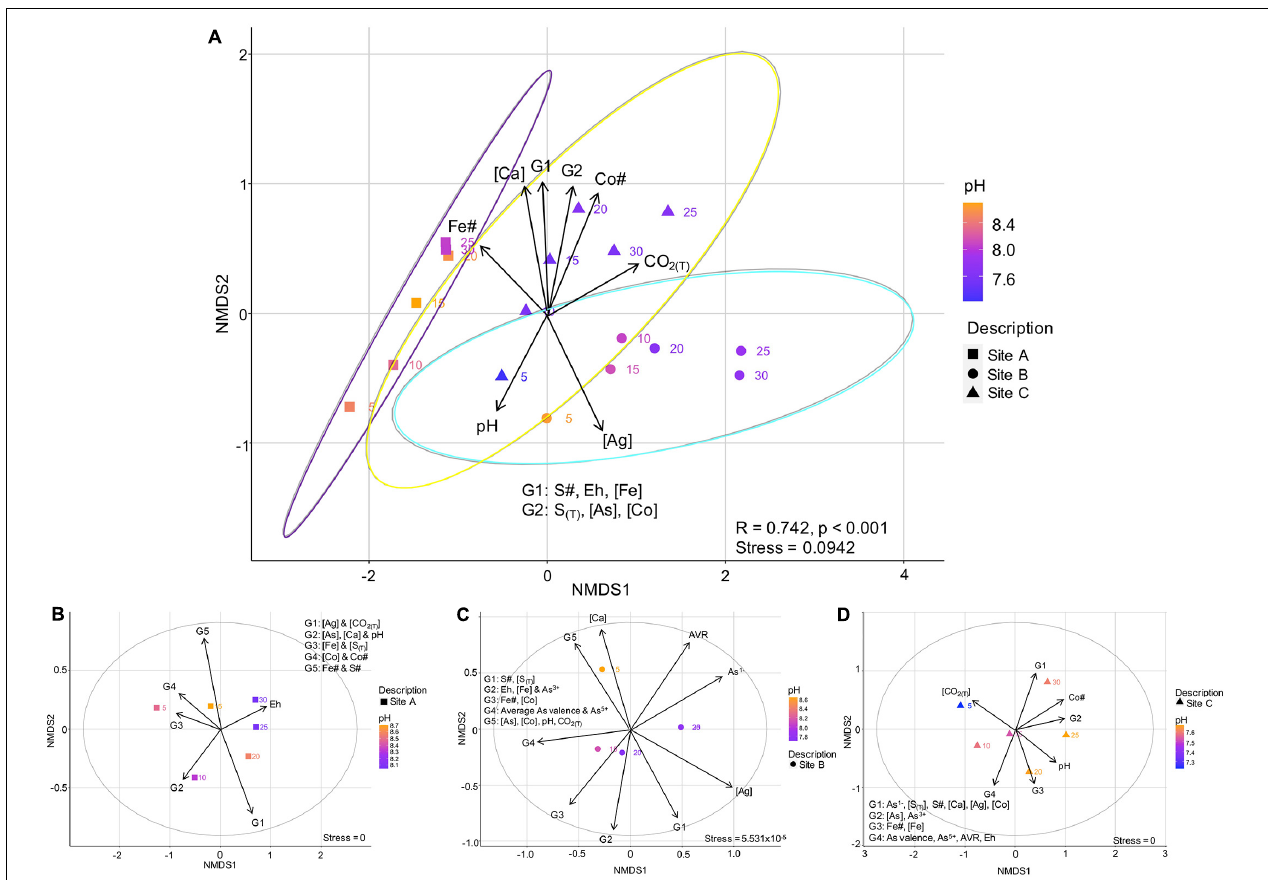
FIGURE 8 | Non-metric multidimensional scaling plot showing the variation in environmental and geochemical variables with site, and their effect on the microbial communities of sites A, B, and C (A) ; Site-specific NMDS plots showing how the enviromental and geochemical parameters effect the microbial community within the tailings samples of site A (B) , site B (C) , and site C (D) . The equation for the average As valence ratio (AVR) is given in Eq.